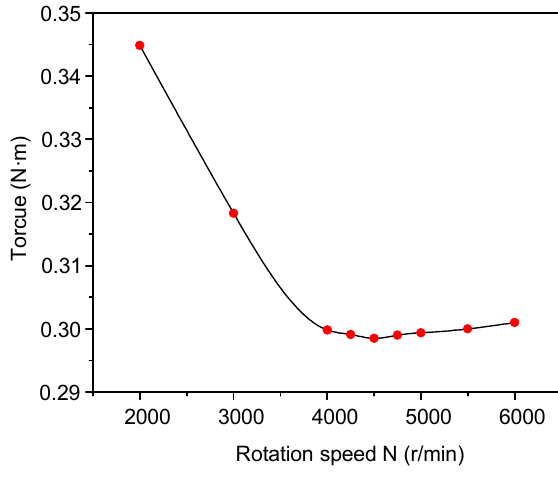
ff erent rotation Figure 9. Torque at different rotation speeds. Figure 9. Torque at di Figure 9. Torque at different rotation speeds.